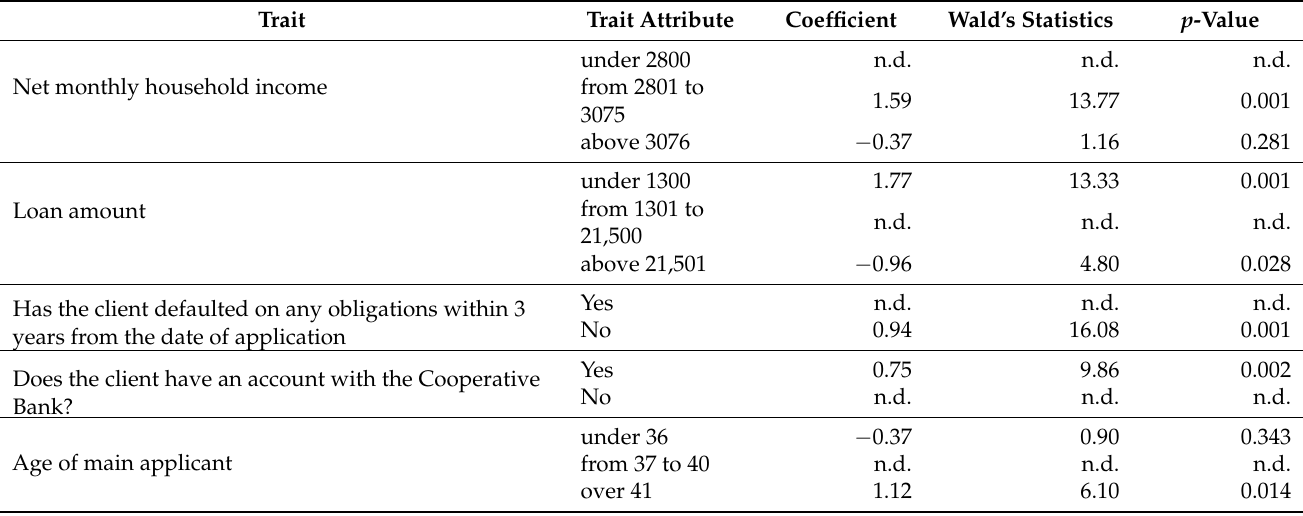
Table 5. Credit risk logit model for Bank A.